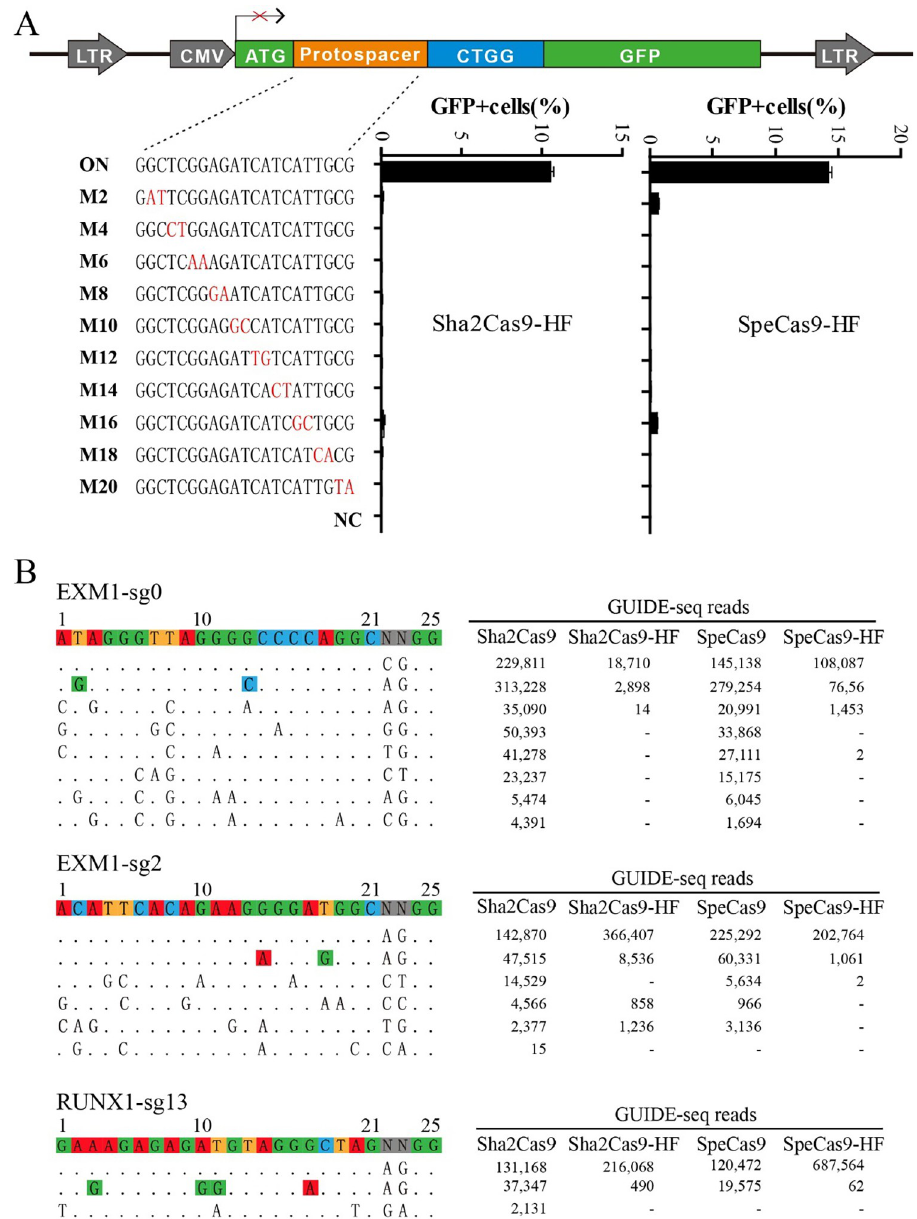
Fig 4. Analysis of Sha2Cas9-HF and SpeCas9-HF specificity. ( A ) Schematic of the GFP activation assay for specificity analysis is shown on the top. A panel of sgRNAs with dinucleotide mutations is shown below. sgRNA activities were measured based on GFP expression. Mismatches are shown in red ( n = 3). Underlying data for all summary statistics can be found in S1 Data. ( B ) Off-targets for EMX1 locus are analyzed by GUIDE-seq. Read numbers for on- and off-targets are shown on the right. Mismatches compared with the on-target site are shown and highlighted in color. Cas9s displayed significantly fewer off-target effects than wild-type Cas9s, reflected by the numbers of off-target sites and off-target read counts. For example, SpeCas9 and SpeCas9-HF generated similar read counts (225,292 versus 202,764) at the EXM1-sg2 site. SpeCas9 induced four off-target sites, while SpeCas9-HF induced two off-target sites. For one off-target, SpeCas9